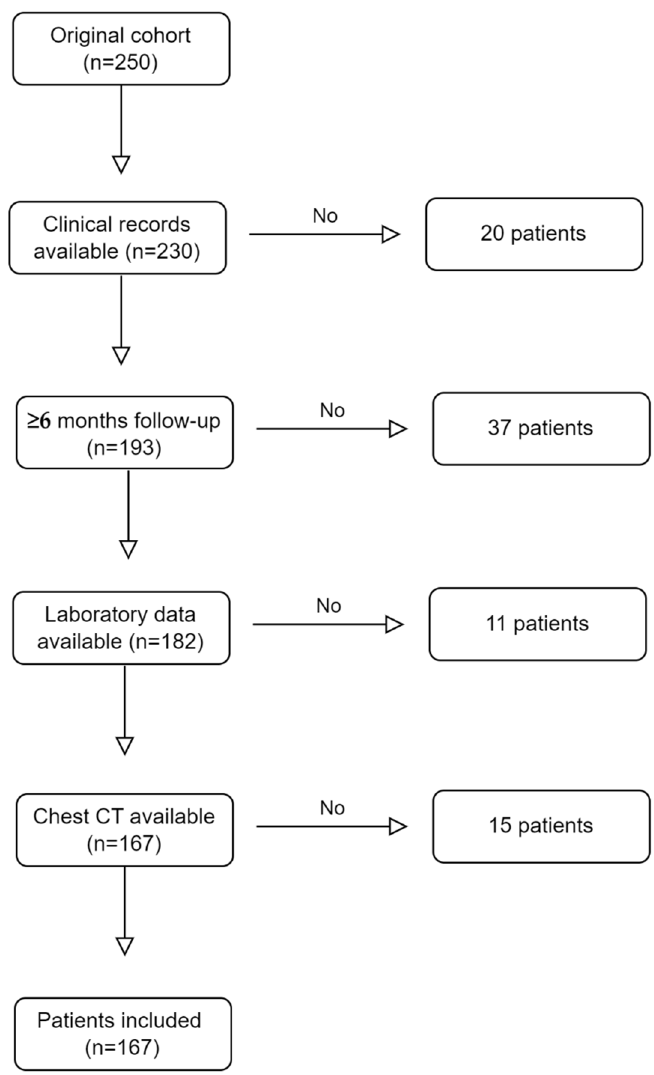
Figure 1. Inclusion and exclusion criteria for the study enrollment. CT: chest tomography.